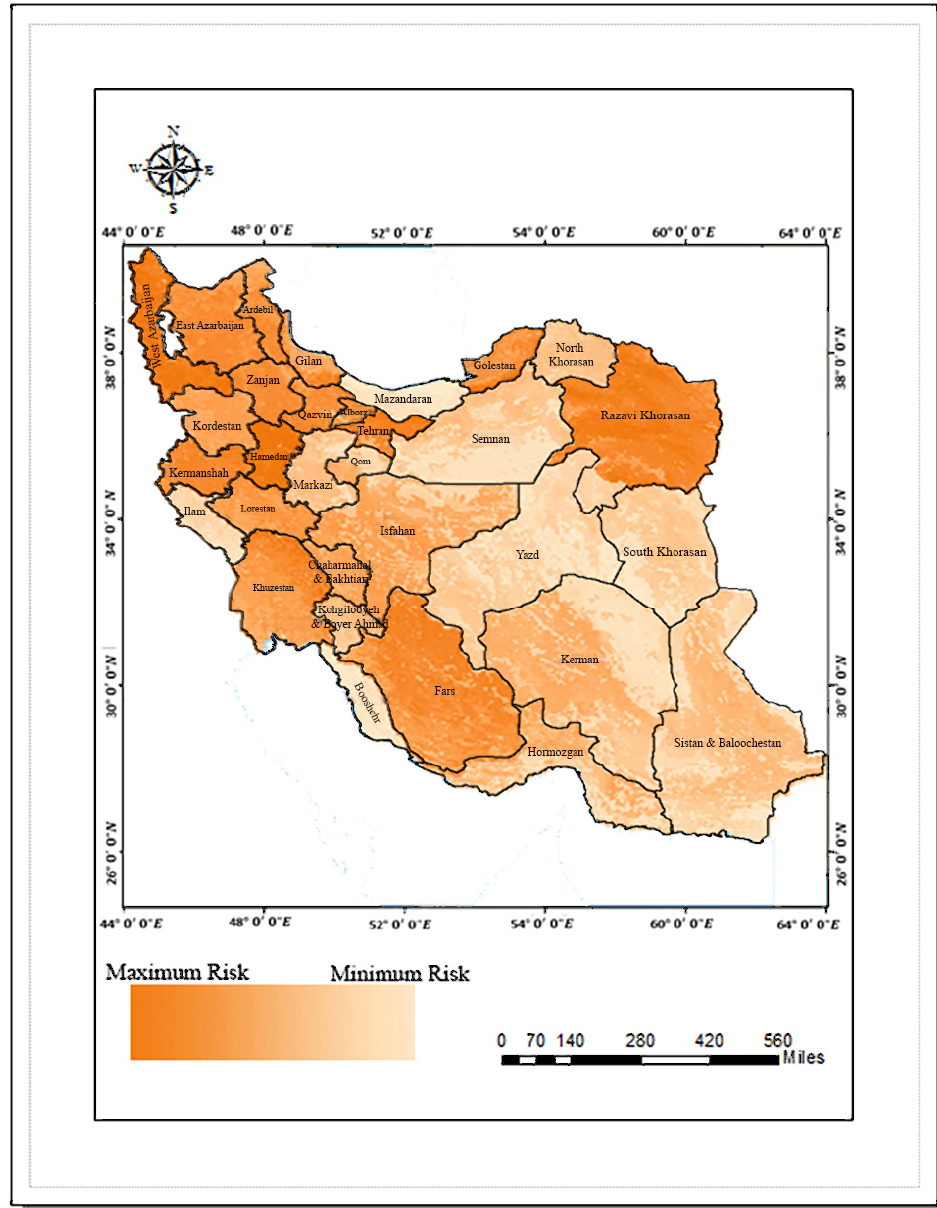
Figure 13. Iran drought risk map (2016).